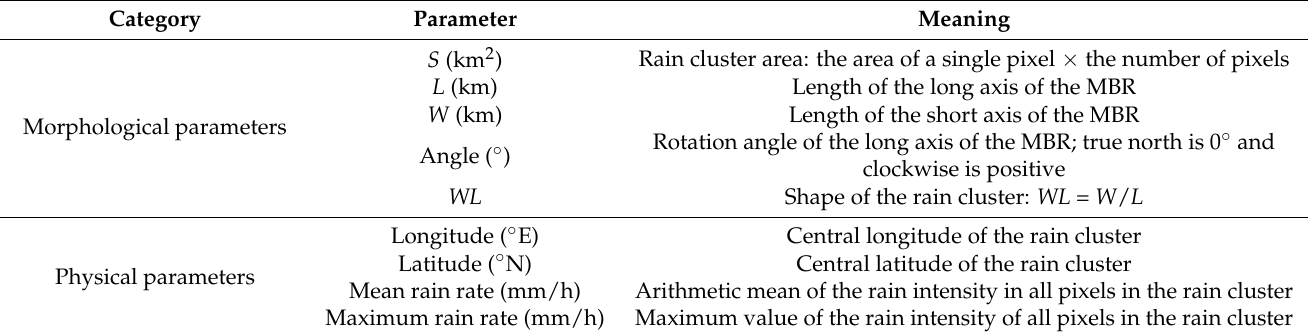
Table 1. Definition of rain cell parameters.